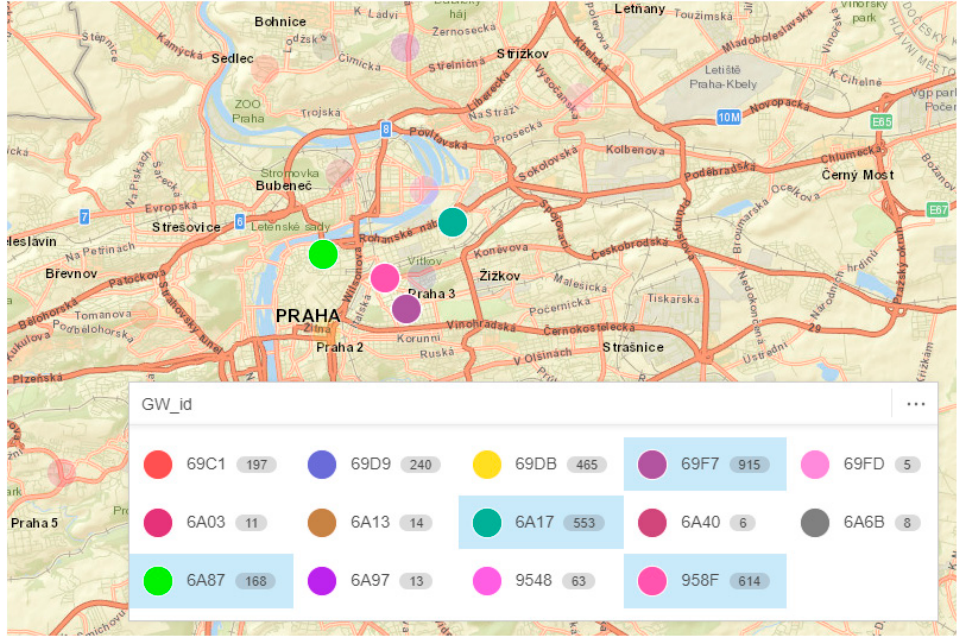
Figure A2. In the picture, you can see the table of individual gateways, where the number in the gray field indicates the number of received messages. The blue-colored fields are those gateways that have received a message on the frequency of 868.1 MHz.